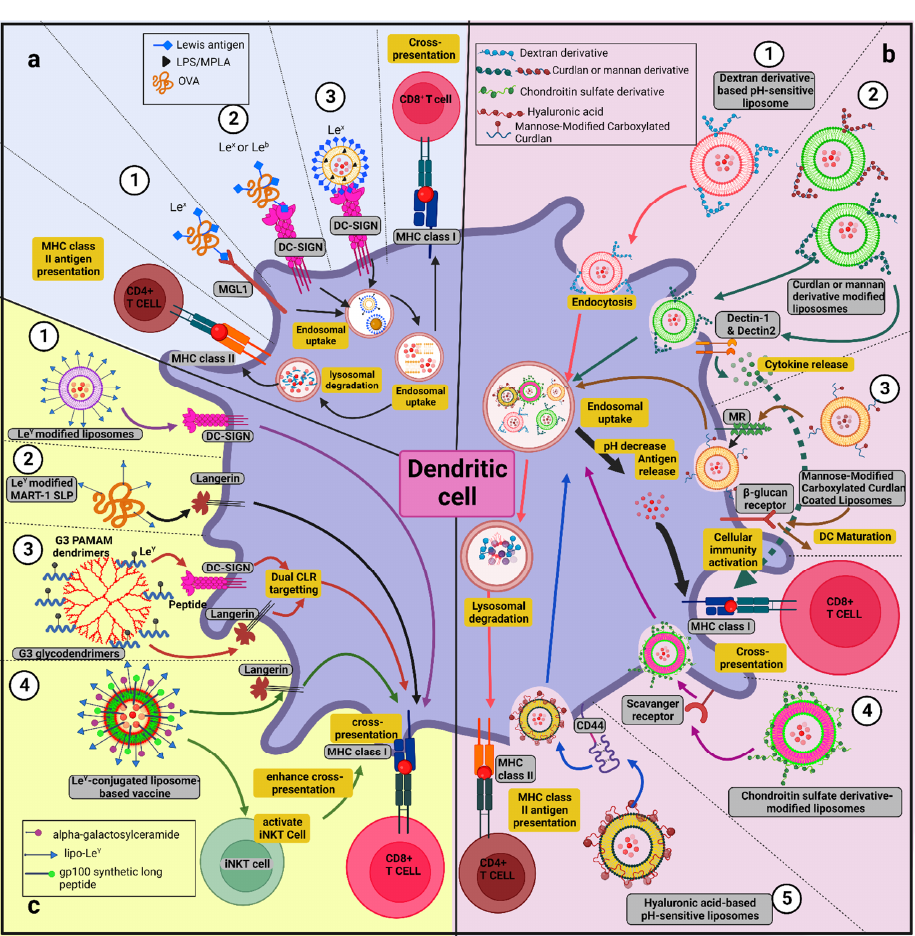
Figure 3. Glycan-mediated strategies for DC targeting via CLRs for enhanced antigen cross-presentation. ( a ) Lewis antigen-modified ovalbumin (OVA)/nanocarriers are as follows: (1) Le x -modified OVA redirected to MGL1 promotes Th1 skewing of CD4 + T cells and CD8 + T cell cross-priming; (2) Le x - or Le b -modified OVA antigens are internalized by DC through DC-SIGN-mediated uptake which promotes CD4 + and CD8 + T cell responses; (3) the MPLA-modified Le x conjugated liposomes are internalized by a DC-SIGN specific manner into the DCs to further enhance CD8 + cross-presentation; ( b ) Glycan-coated pH-sensitive liposomes are as follows: (1) carboxylated dextran derivative-modified pH-sensitive liposomes enhance the pH-sensitive endo-lysosomal degradation and promote CD4 + and CD8 + immune responses; (2) Curdlan and mannan derivative-modified liposomes are recognized by Dectin-1 and -2, respectively, which are endocytosed into the DCs and, due to weak pH conditions, the endosome disrupts to release antigens into the cytosol for proteasomal degradation to be further presented on the cell surface, which leads to enhanced CD8 + T cell response; (3) Mannose-modified curdlan-coated liposomes are recognized by MR which transfers the liposome to the endocytic compartment for degradation and, furthermore, the pH-sensitive environment induces the antigen release into the cytosol for proteasomal degradation for further antigen presentation to CD8 + T cells. Additionally, they are also recognized by β -Glucan receptors to promote DC maturation; (4) To induce antigen-specific cellular immunity, chondroitin sulphate derivative-modified liposomes would be specifically taken up by APCs cells via scavenger receptors and these encourage cytokine production from the cells as well as the endosomal escape of antigenic proteins through pH-responsive membrane destabilization; (5) Hyaluronic acid-based pH-sensitive polymers are recognized by CD44 present on APCs. These liposomes were successful in delivering model antigenic proteins into the cytosol of DCs and releasing the degraded antigenic peptide into the cytosol, which was then loaded onto the MHC class I molecules and elicited CD8 +